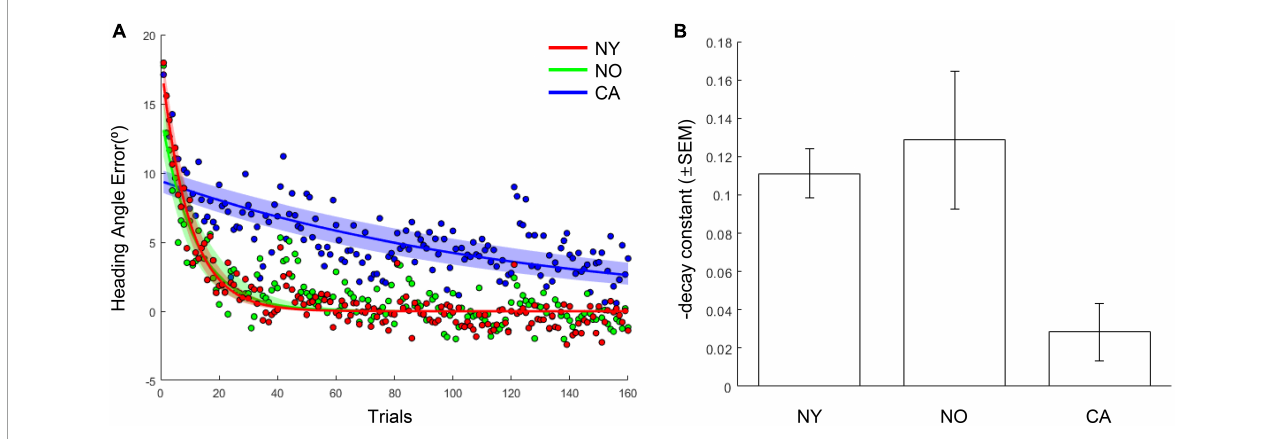
FIGURE5 The learning curves and adaptation coefficients in NY, NO, and CA groups. (A) The averaged heading angles and their fitted curves in the form of exponential decay in NY, NO, and CA groups. The shaded area depicts 95% confidence intervals on fitted functions. (B) The averaged learning rates (decay constants) in each group. For intuitive understanding, the negative sign of decay constants was flipped to the positive